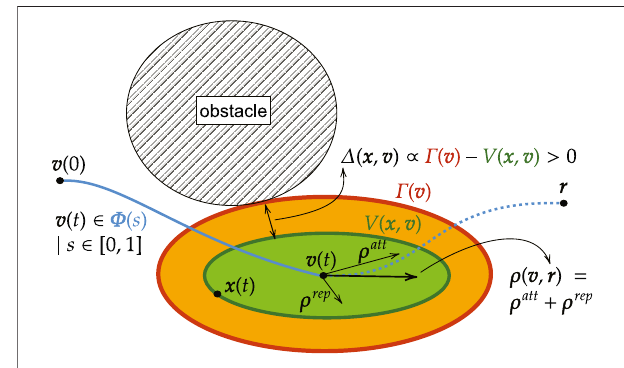
FIGURE 4 | Basic Idea of the Invariant Level Set Explicit Reference Governor − Thesphericalobstacleisavoided bymoving theappliedreference v ( t ) over the a priori unknown (i.e. non pre-computed) path Φ ( s ) of steady- state admissible equilibria. The green ellipsoid represents the invariant level set value V ( x , v ) which embeds the future trajectory of x ( t ) if the current v ( t ) were to remain constant. The orange ellipsoid represents the threshold value Γ ( v ) of the invariant level set that touches the obstacle constraint. The Dynamic Safety Margin (DSM) Δ ( x , v ) is proportional to the difference between these level-set values and represents how safe it is to change v ( t ) in the direction of the Navigation Field (NF) ρ ( v , r ) , with attraction toward the desired reference r and repulsion away from